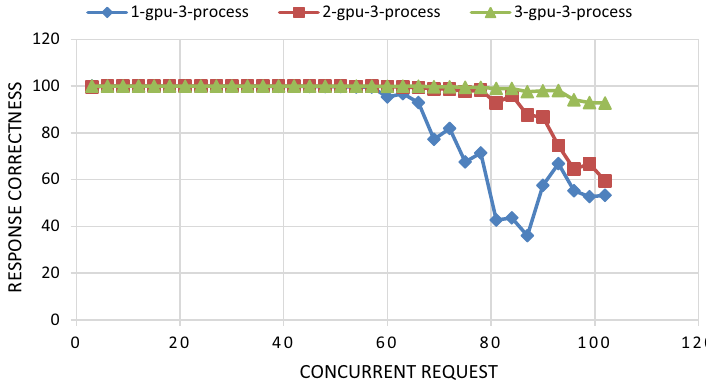
Fig. 7 Response correctness based on concurrent requests for 1, 2, 3 GPU with three